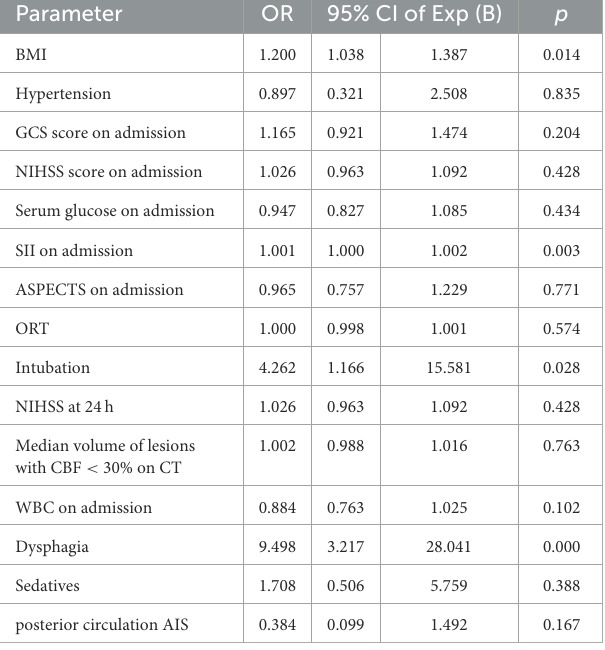
TABLE 2 Logistic regression analysis of possible predictive factors of developing poststroke pneumonia after mechanical thrombectomy.